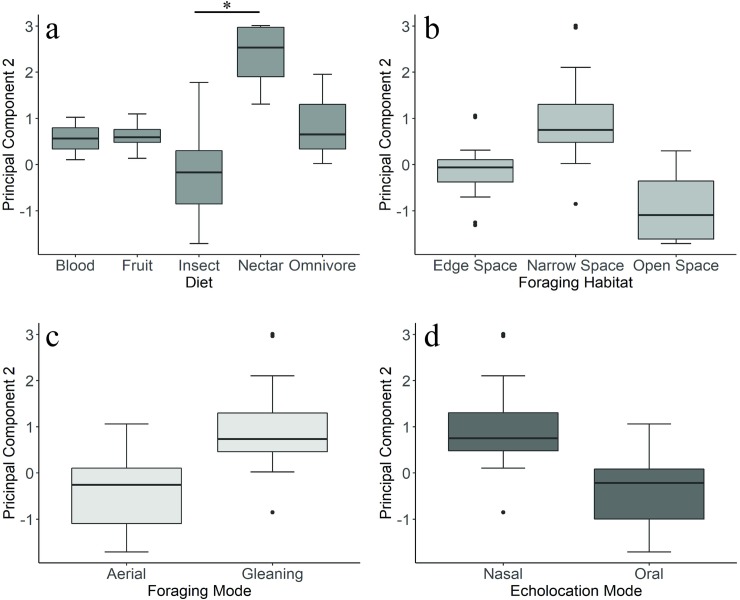
Boxplots representing variation in PC2.Data from the full dataset for four of the measured ecological variables: diet (a), foraging habitat (b), foraging mode (c), and echolocation mode (d). Only diet had a significant effect on PC2 in a PGLS regression. Asterisks indicate statistical significance in a phylogenetic ANCOVA.